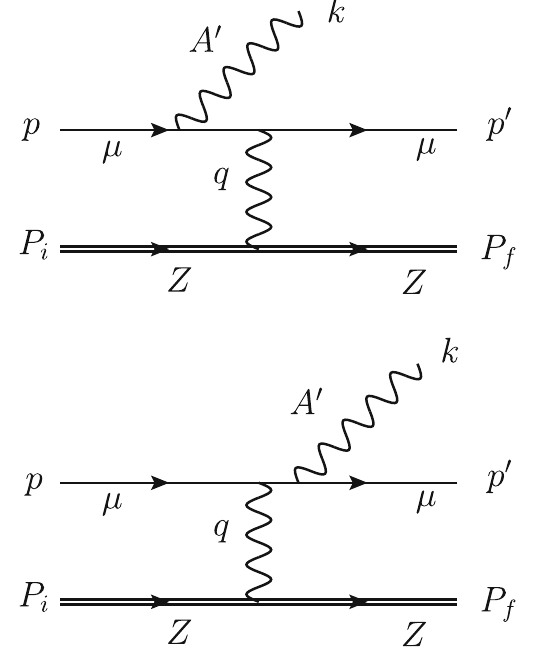
Fig. 3 Initial and final state bremsstrahlung production of a muon- philic vector boson A (cid:5) in muon-nucleus scattering